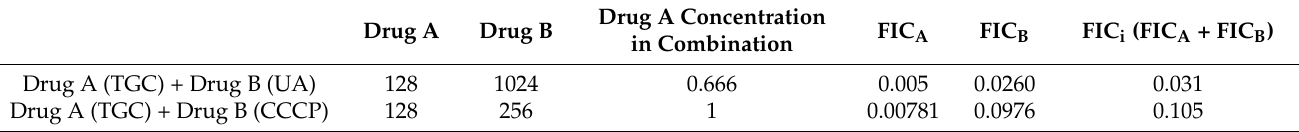
Table 3. FICI concentrations for TGC + (+)UA and TGC + CCCP.